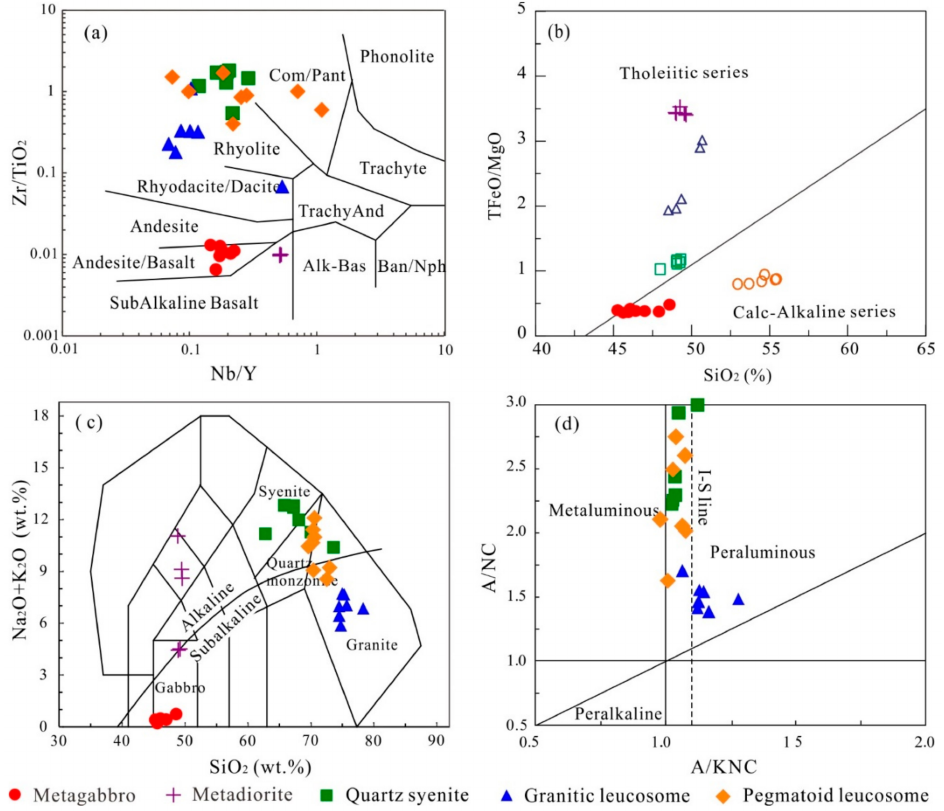
Figure 4. ( a ) Nb/Y-Zr/TiO 2 (modified from [47]); ( b ) SiO 2 -TFeO/MgO (modified from [48]); ( c ) SiO 2 -MALI diagram (modified from [49]); ( d ) A/KNC-A/NC diagram (modified from